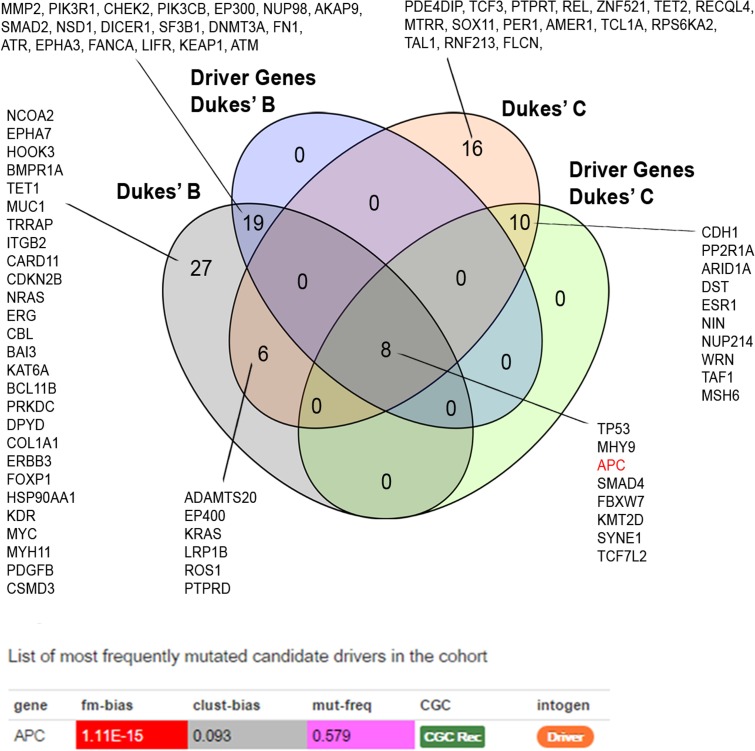
Venn diagram illustrating the overlapped altered genes. APC alterations were identified as the most frequent significant driver gene in our patients. Driver prediction was performed using IntOGen (Gonzalez-Perez et al., 2013).